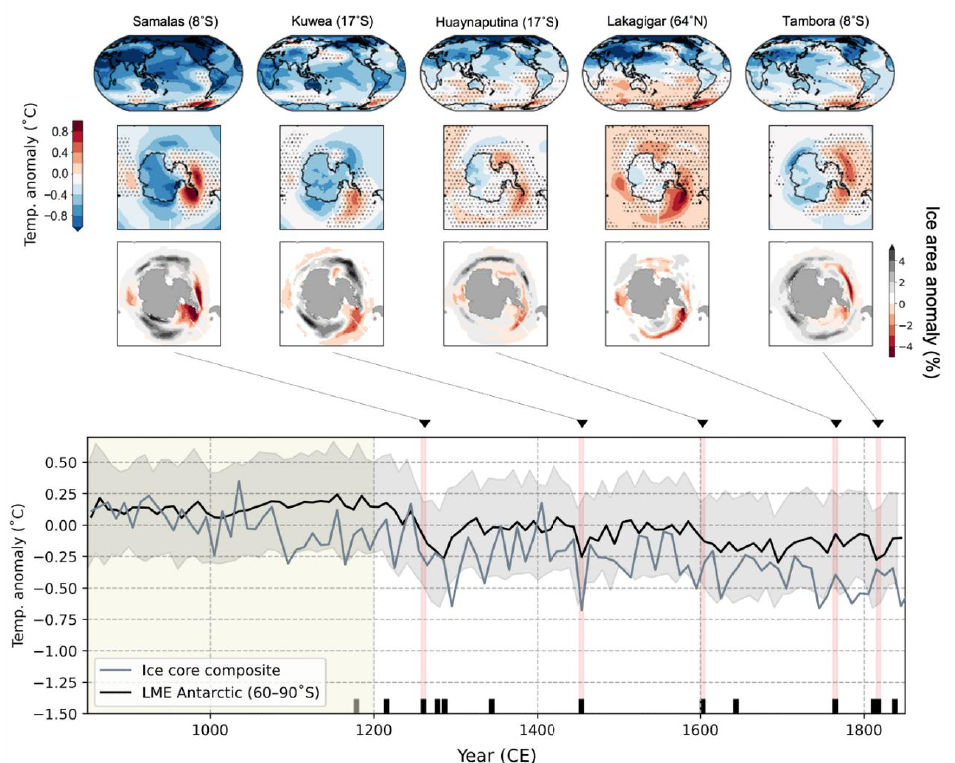
Figure 5. LM average Antarctic (60–90 ◦ S) air temperature evolution LME full forcing ensemble mean compared to composite ice core temperature reconstructions from Antarctica compiled in Stenni et al. [23]. Anomalies were computed in 10-year bins relative to the 850–1200 CE mean (highlighted in beige) to facilitate comparison to ice core reconstructions. Black bars highlight the timing of the 13 largest LM volcanic eruptions (peak global-mean aerosol mass mixing ratios above 1 × 10 8 ). Map insets ( top ) show the average temperature anomaly ( ◦ C) and sea ice area anomaly (%) in the 5 years after the five largest LM volcanic eruptions ( bottom , shown in red). Anomalies were computed relative to the prior 50-year mean. Stippling indicates differences that were not statistically significant at the 95% level using a Students t -test.